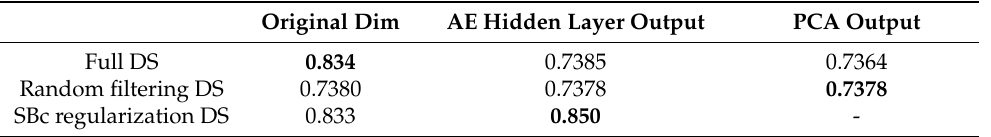
Table 2. Results of GB-based classification of the datasets with different filtering methods and different feature sets. The stabilized barycenter-based (SBc) method limits the cluster size to be in range 20–80%. The ID s obtained cluster size is 1709 with 1341 of outliers ( UD s).